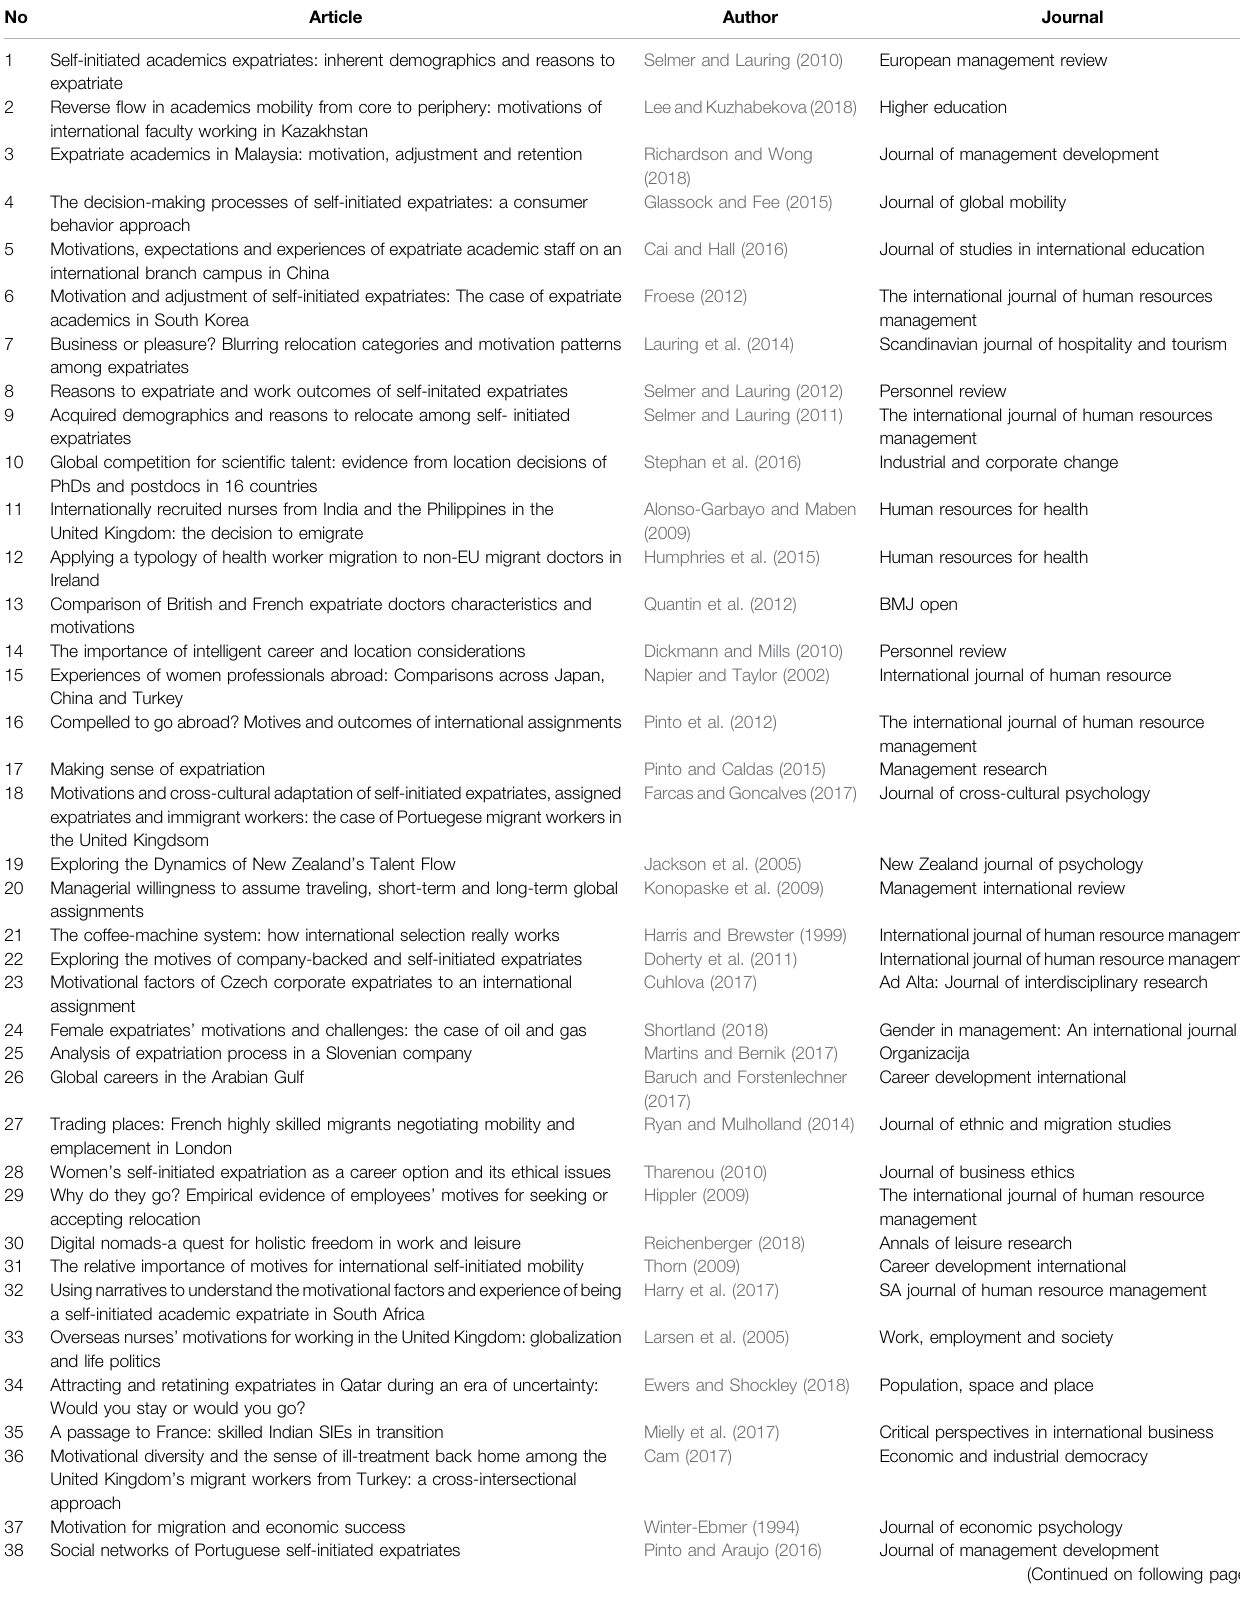
TABLE 1 | Overview of articles included in fi nal